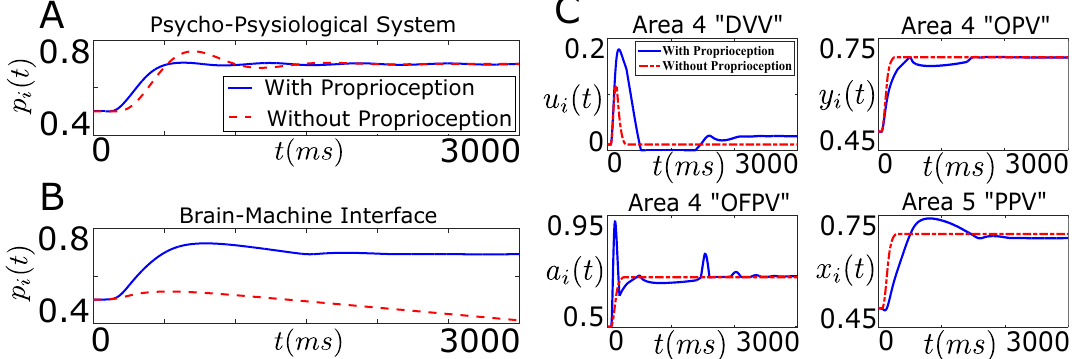
Figure 7. Degradation in the performance of BMI in the absence of proprioception. ( A , B ) show the position trajectory of the agonist muscle i ( p i ( t ) ) as a function of time ( t ) in the presence (solid line) and in the absence (dotted line) of the natural proprioceptive feedback information. ( A ) shows the position trajectory for the neurophysiological system (“Psycho-Physiological System”) while ( B ) shows the position trajectory for the designed BMI (“Brain-Machine Interface”). The desired position target ( T i ) for the agonist muscle i in ( A , B ) is 0.7; ( C ) shows the average firing activity of a population of agonist area 4 “DVV” ( u i ( t ) ), area 4 “OPV” ( y i ( t ) ), area 4 “OFPV” ( a i ( t ) ) and area 5 “PPV” ( x i ( t ) ) neurons in the presence (solid line) and in the absence (dotted line) of the natural proprioceptive feedback information for the designed